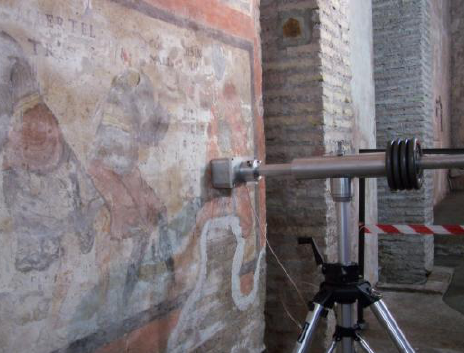
Figure 2. Portable unilateral NMR instrument measuring the moisture content in the wall painting Saint Clement at Mass and the Legend of Sisinnius in St. Clement’s Basilica,